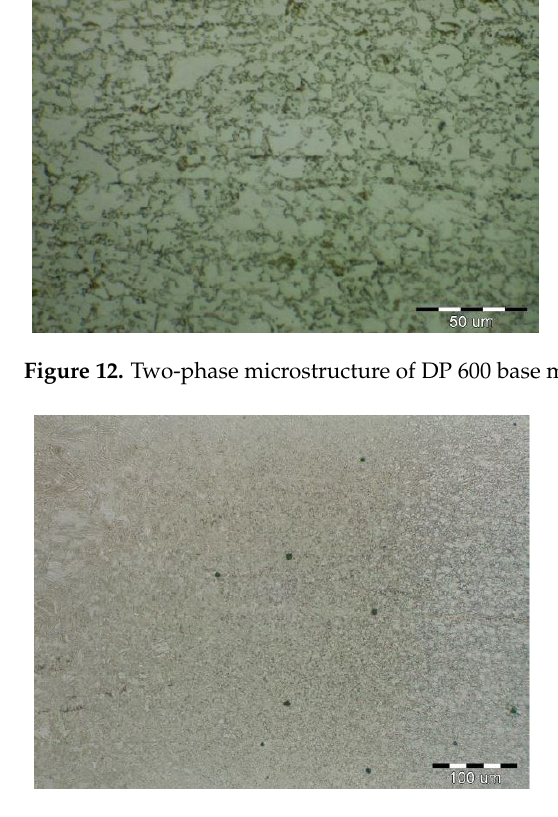
Figure 13. Microstructure of thermally affected area sample B (DP600).